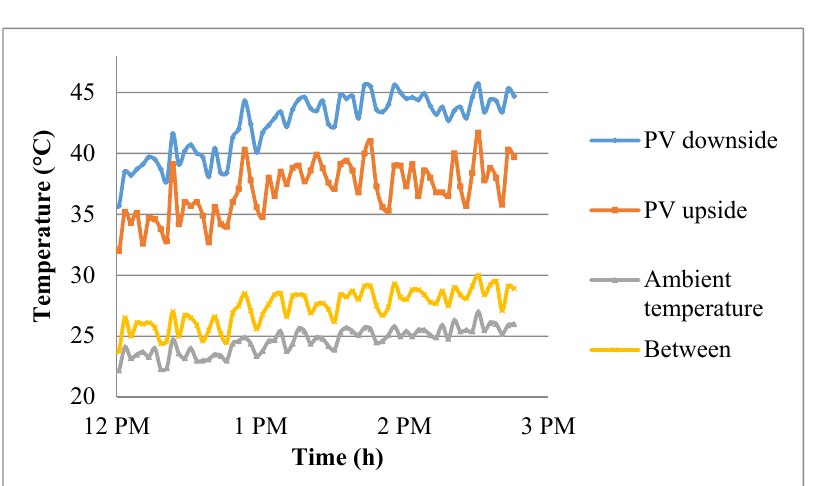
Figure 7. Time dependencies of polycrystalline photovoltaic module parts temperature, ambient temperature, and temperature between photovoltaic module and roof sheet.